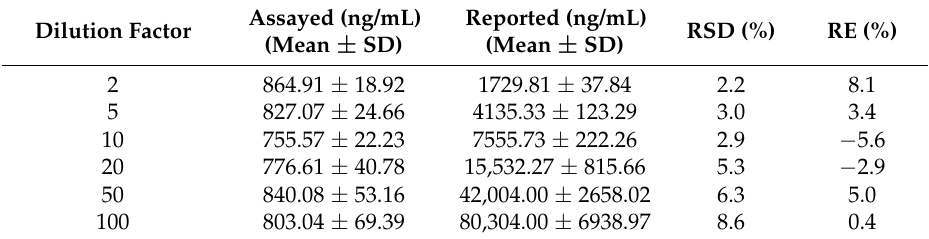
Table 4. Summary of dilution effects of sodium danshensu in beagle dog plasma ( n =